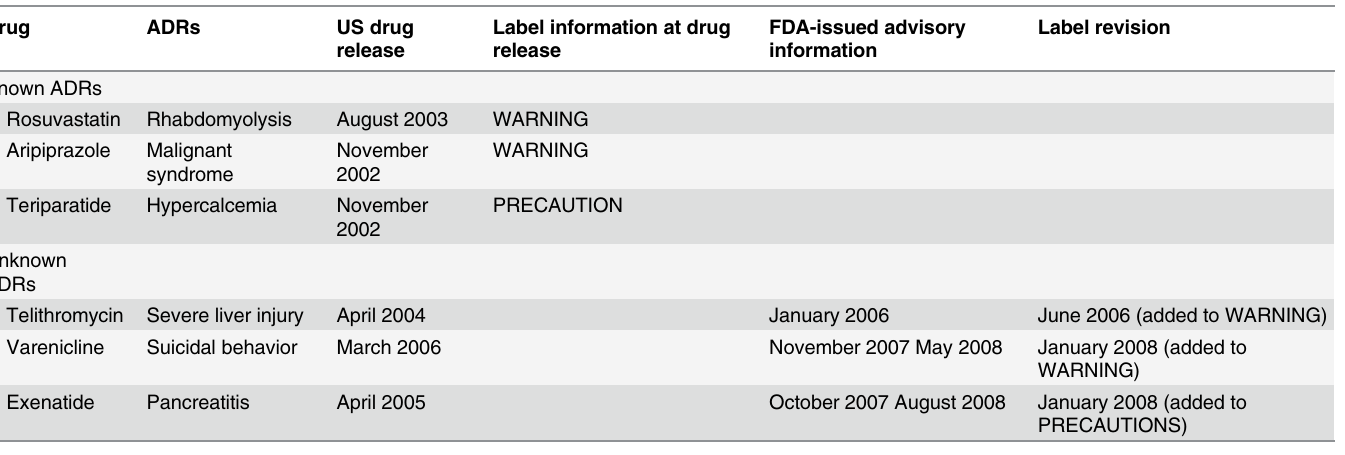
Table 1. Label Information on ADRs for each